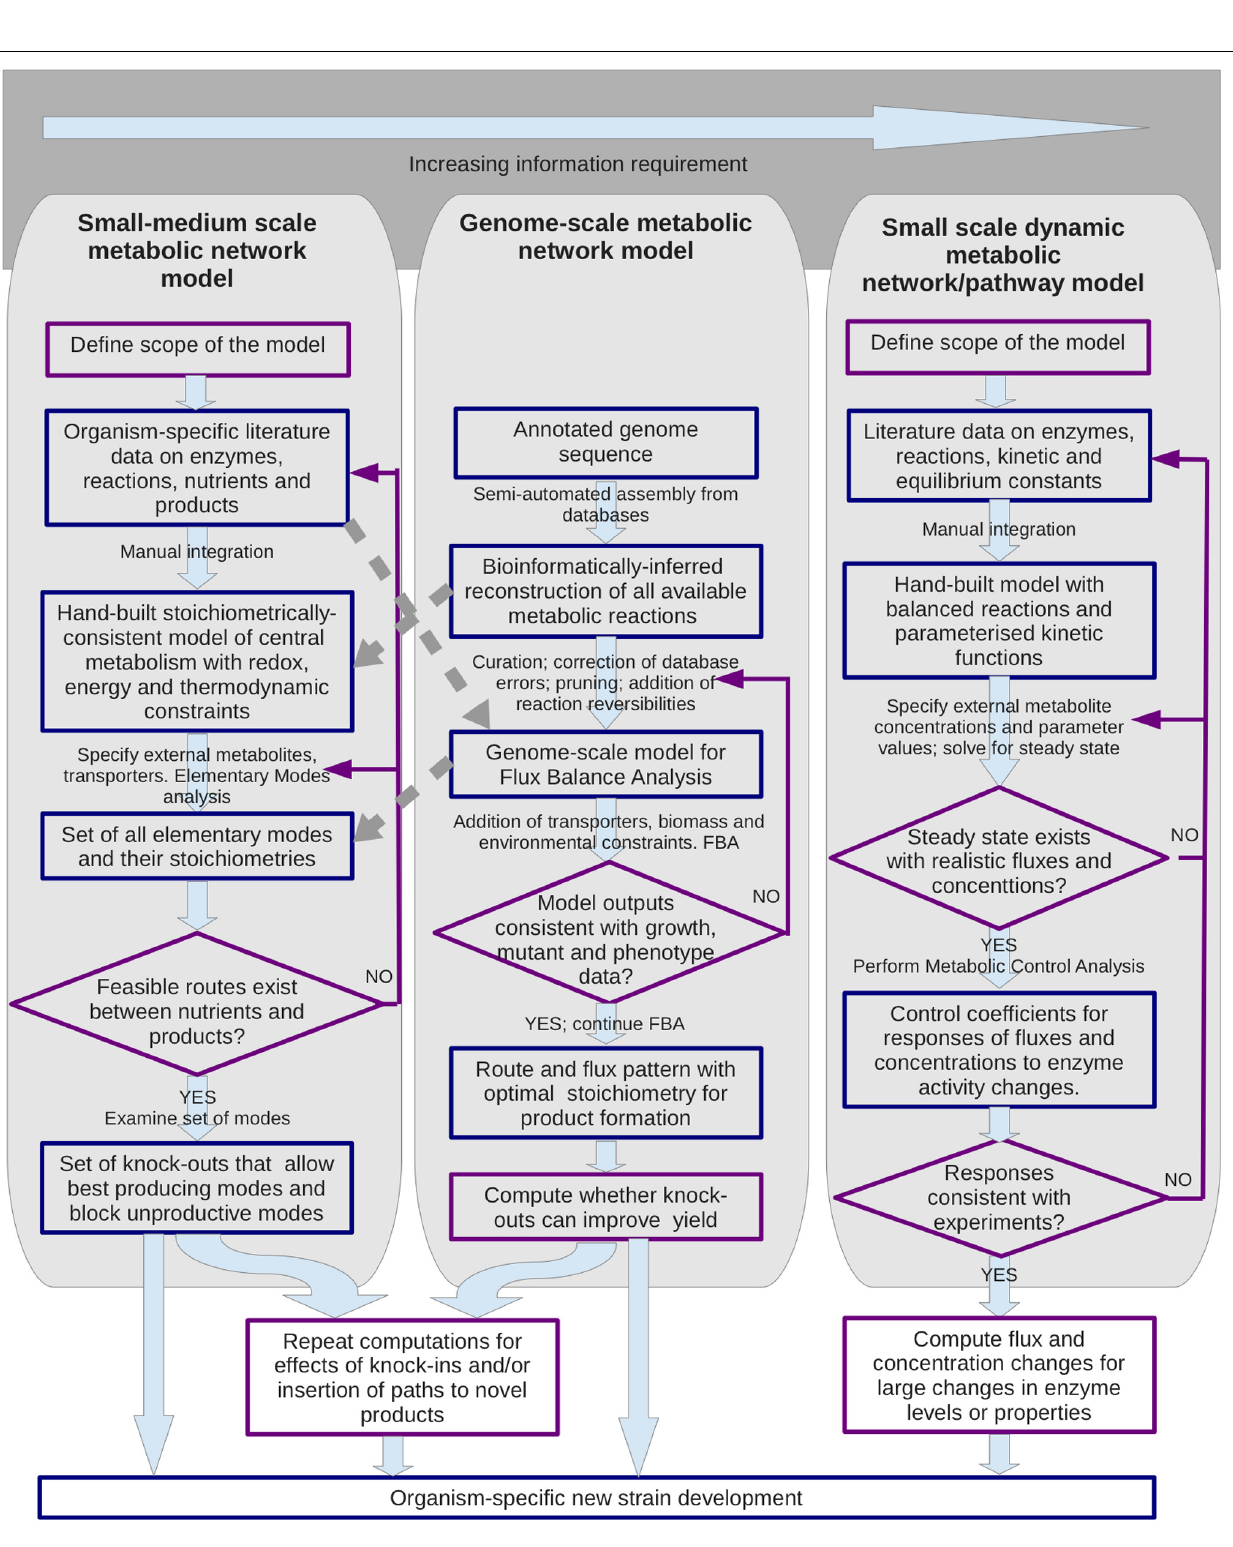
approaches shown on the left and center can have some cross-talk as indicated by the broken arrows. Blue boxes indicate entities such as data sets and models; purple outlines indicate